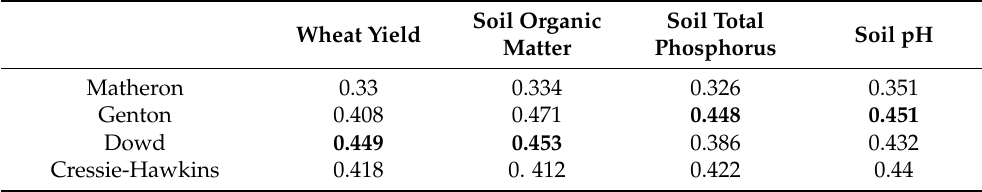
Table 3. The medians of the standardized square prediction error ( SSPE ) generated by leave-one-out cross-validation.